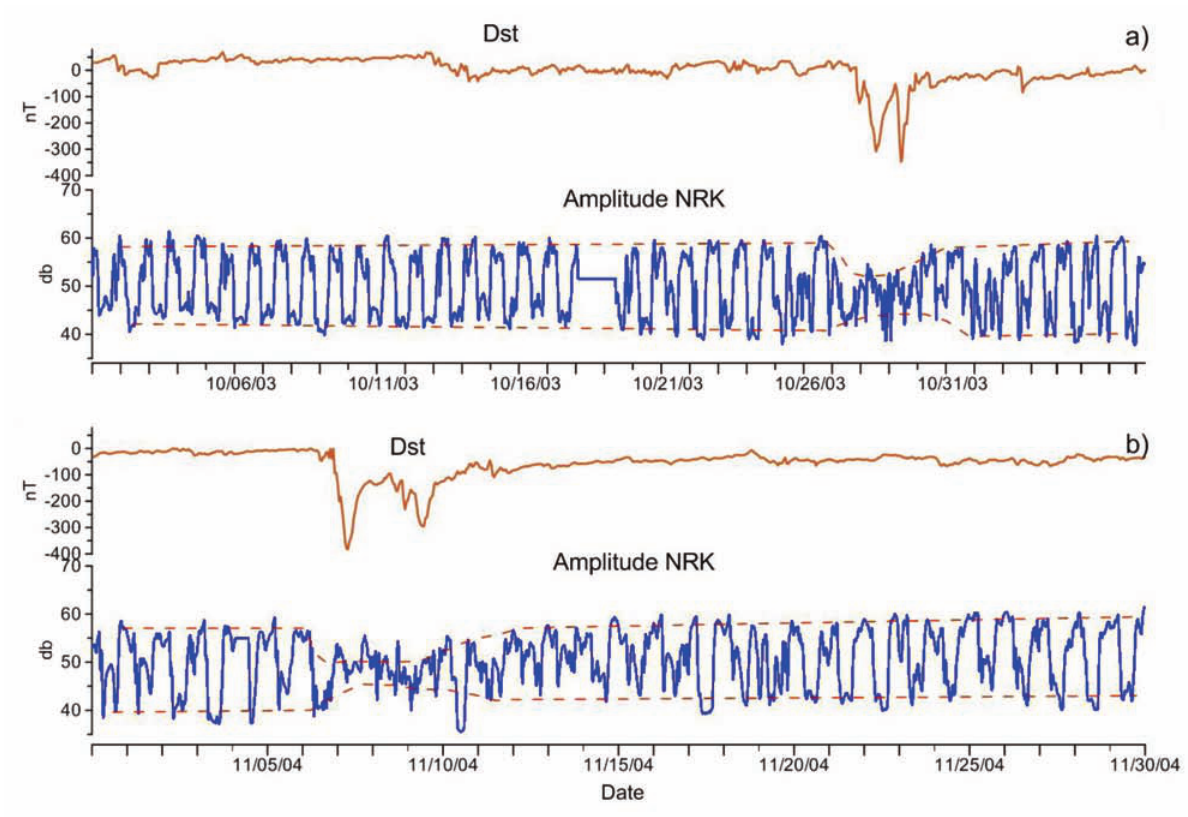
Figure 2. Variations in the amplitudes of the LF signals in the NRK-Bari wave path during periods of strong magnetic activity. (a) A magnetic storm from October 28-31, 2003. (b) A magnetic storm from November 8-10,